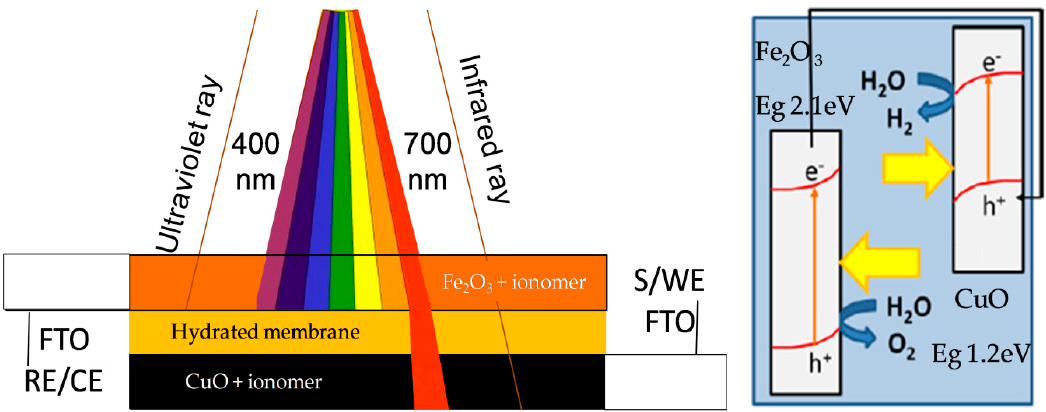
Figure 2. Schematic optical ( left ) and electronic ( right ) sketch of the photoelectrochemical cell (PEC) under solar irradiation.